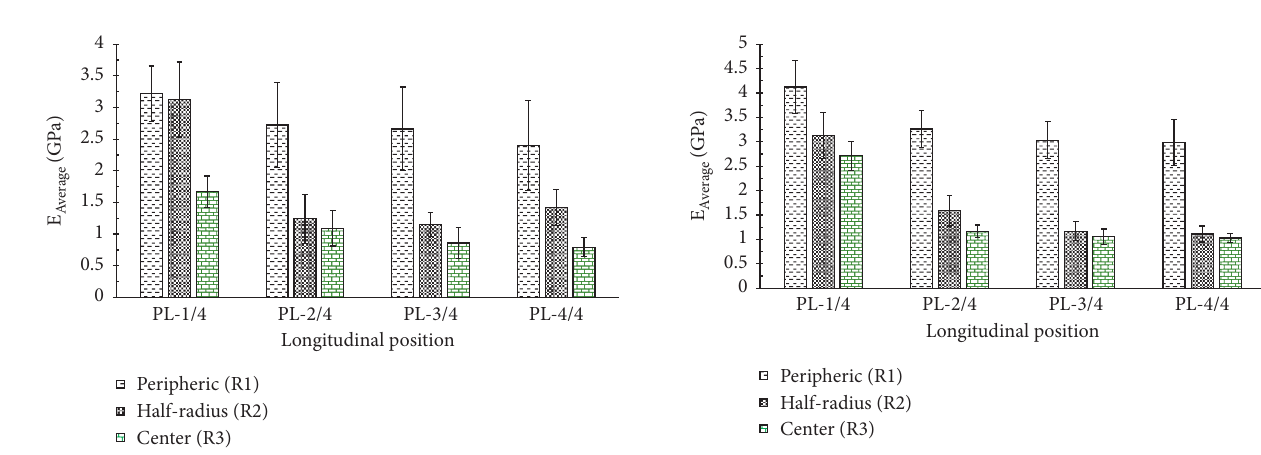
Figure 9: Distribution of Young’s modulus in the tensile test of the RVP along the stem.